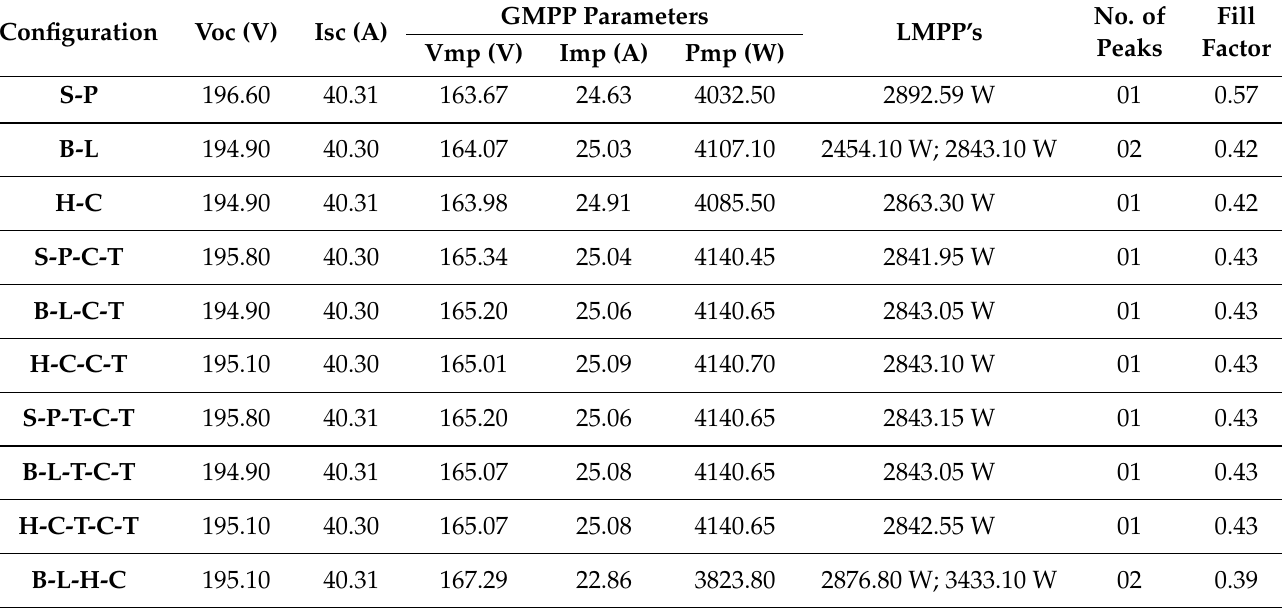
Table 8. Parameter variations of conventional and hybrid configurations under LAW